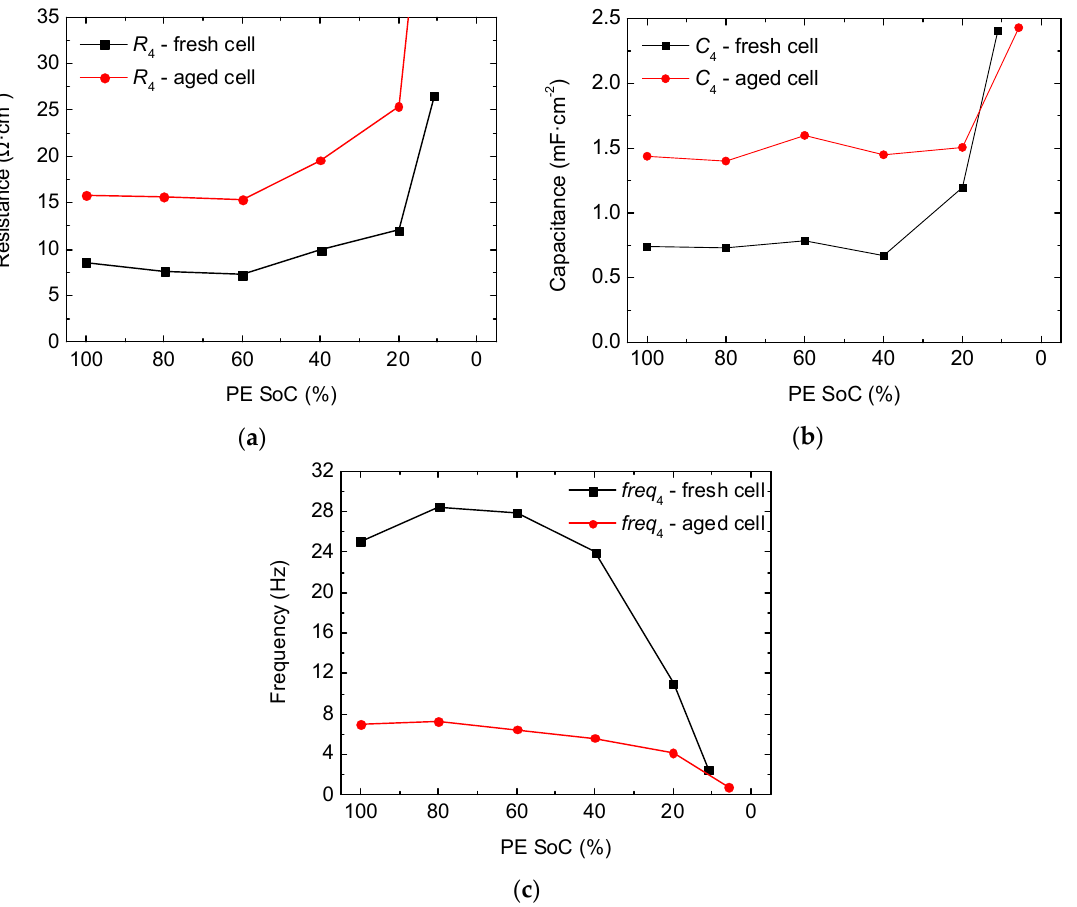
Figure 7. ( a ) Resistance, ( b ) capacitance, and ( c ) characteristic frequency related to P4_PE measured at the LCO-NMC/Li half-cell at 25 °C. P4_PE is related to charge transfer at the positive electrode. the LCO-NMC/Li half-cell at 25 ◦ C. P4_PE is related to charge transfer at the positive